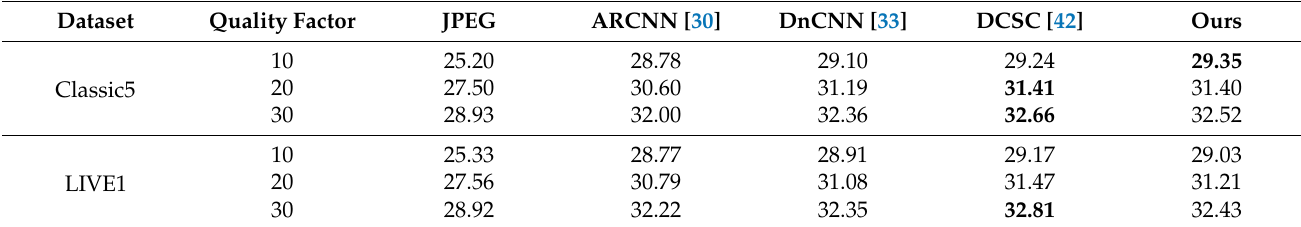
Table 8. PSNR-B (dB) comparisons on the test datasets. The best results of dataset are shown in bold. Dataset